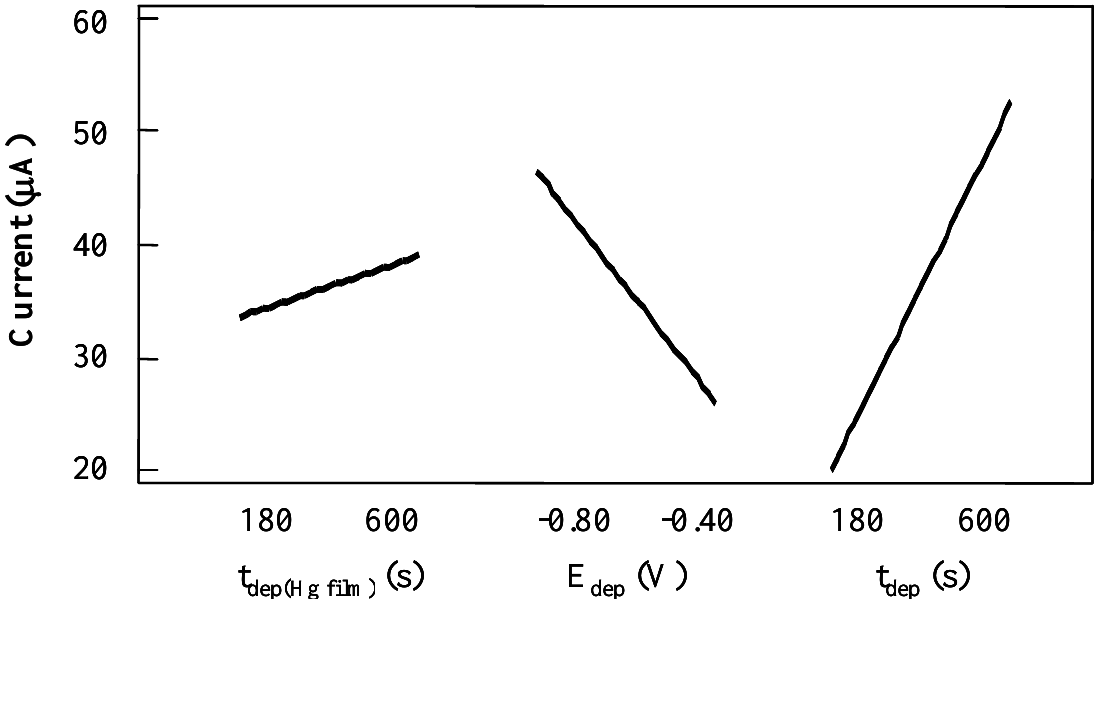
Figure 2. Influence of the main factors in the response in the 2 3 factorial design for optimization of experimental variables in Sb (III) determination by